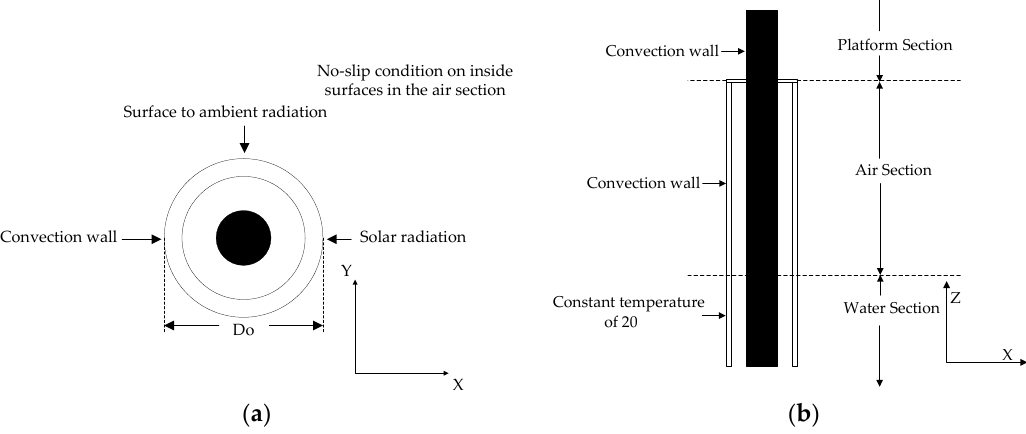
Figure 2. Computational domain and boundary conditions from different views for the enclosed J-tube system: ( a ) view along the negative Z coordinate, and ( b ) view along the positive Y coordinate.